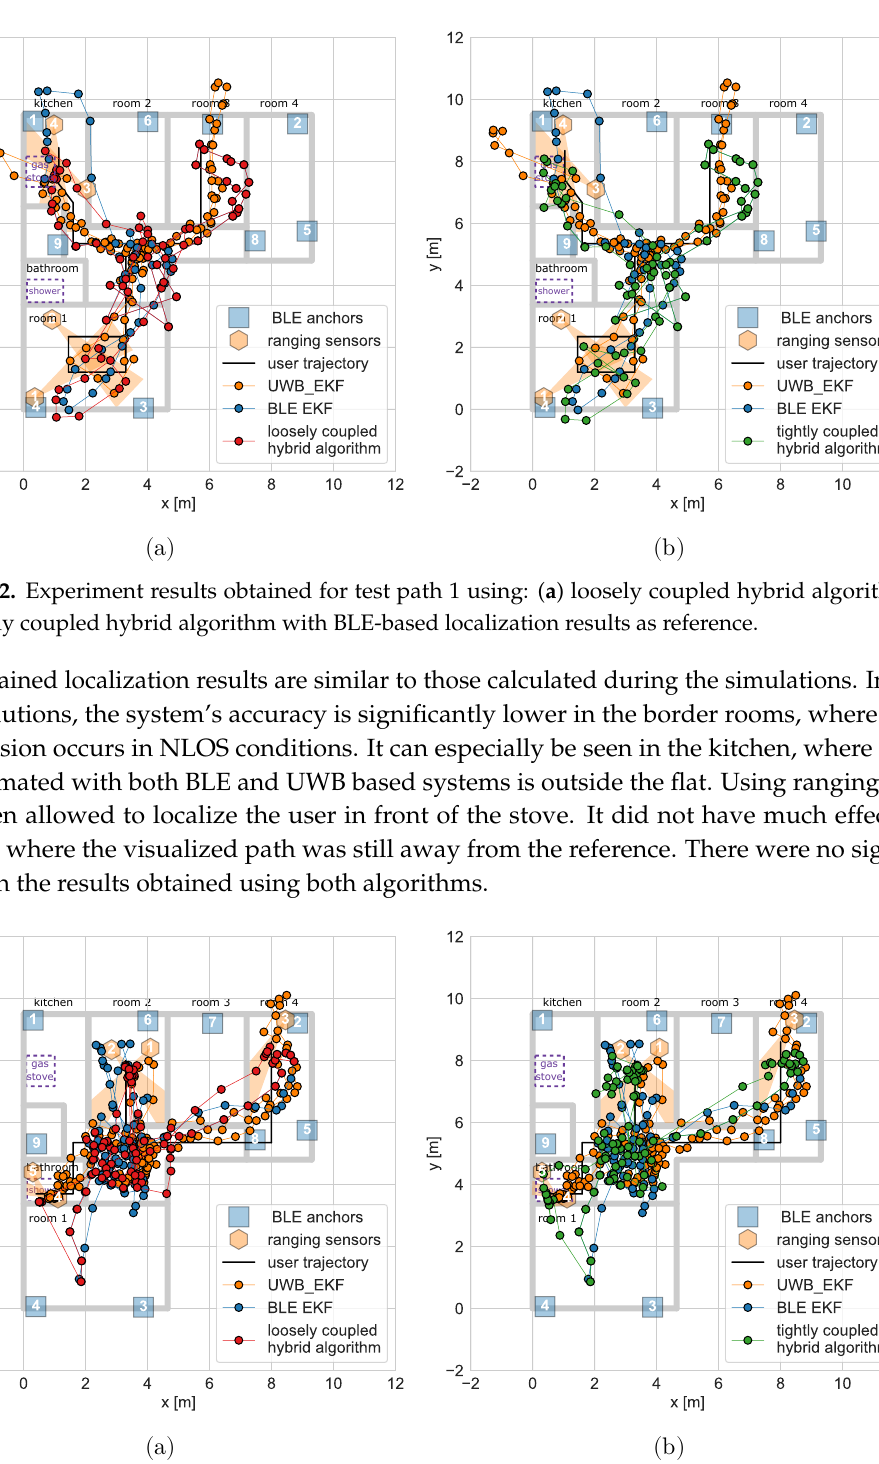
Figure 13. Experiment results obtained for test path 2 using: ( a ) loosely coupled hybrid algorithm, ( b ) tightly coupled hybrid algorithm with BLE-based localization results as